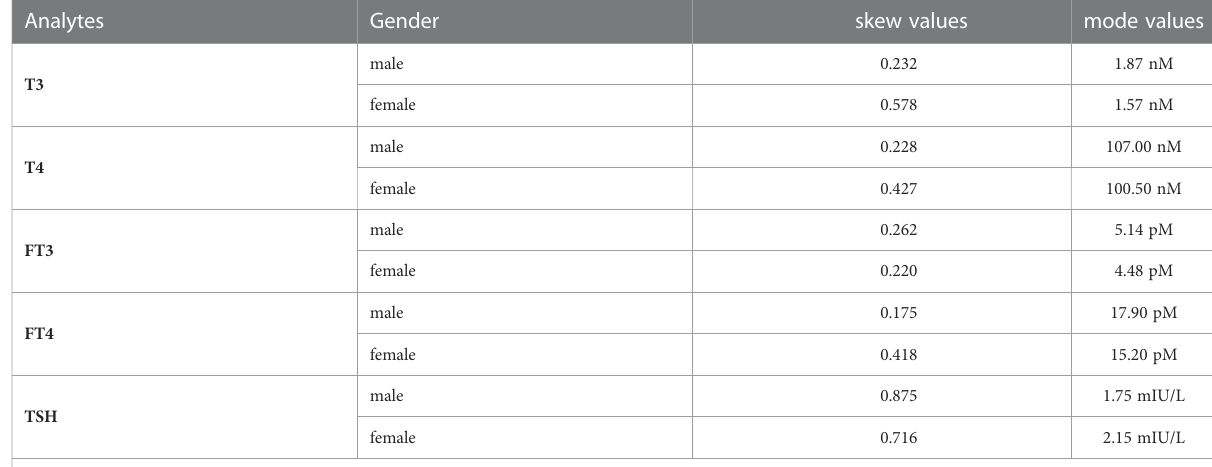
Abbreviations are listed in the legend of Table